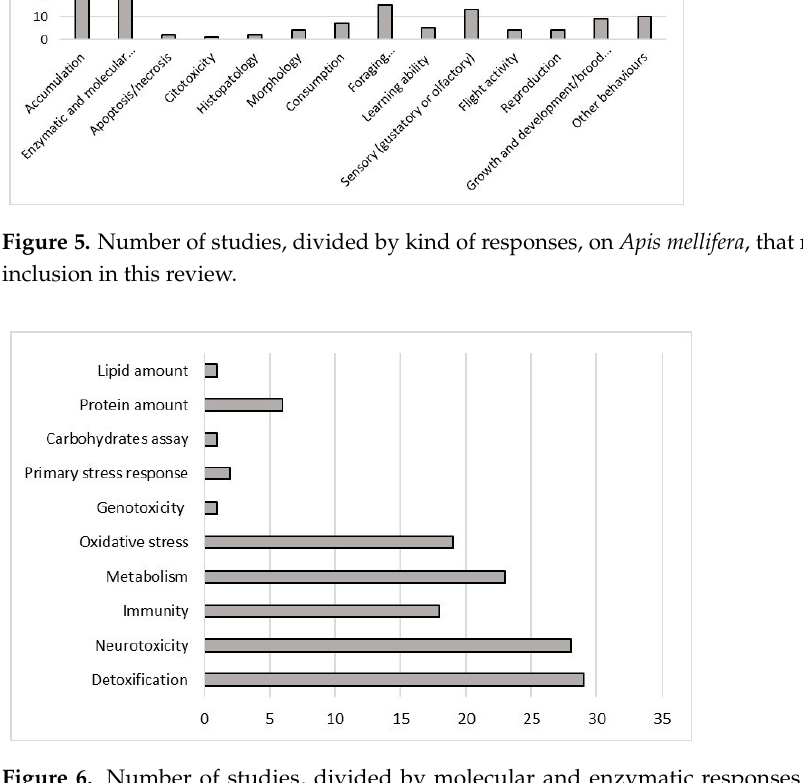
Table 1. Summary of laboratory studies divided by endpoint and contaminants.